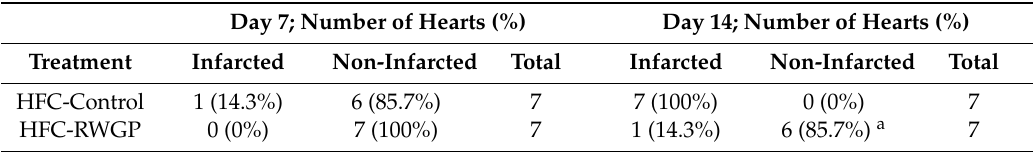
Table 2. RWGP supplementation reduces macroscopic myocardial infarction in atherogenic diet-fed SR-B1 KO / ApoER61 h / h mice. Day 7; Number of Hearts (%) Day 14; Number of Hearts (%) Treatment Infarcted Non-Infarcted Total Infarcted Non-Infarcted Total HFC-Control 1 (14.3%) 6 (85.7%) 7 7 (100%) 0 (0%) 7 HFC-RWGP 0 (0%) 7 (100%) 7 1 (14.3%) 6 (85.7%) a 7 a p < 0.0001 vs. HFC-Control; Chi-squared